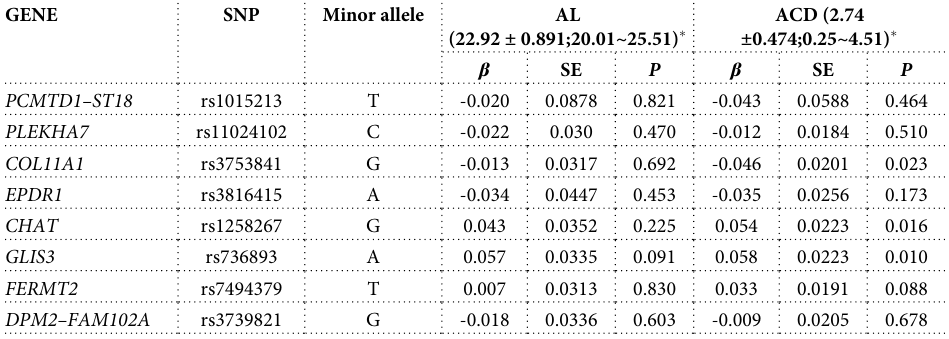
Table 4. Association between the eight PACG susceptibility loci and AL and ACD.